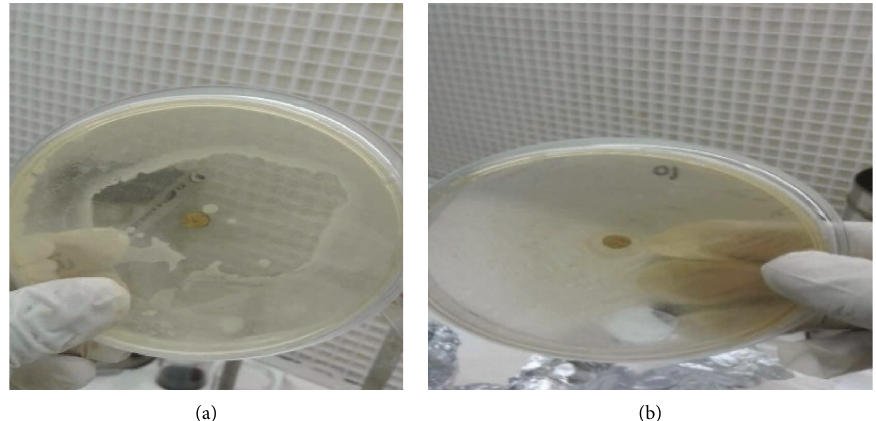
Figure 3: Antimycobacterial activity at 72 hours for (a) the DCM crude extract and (b) the EtOAc crude extract in